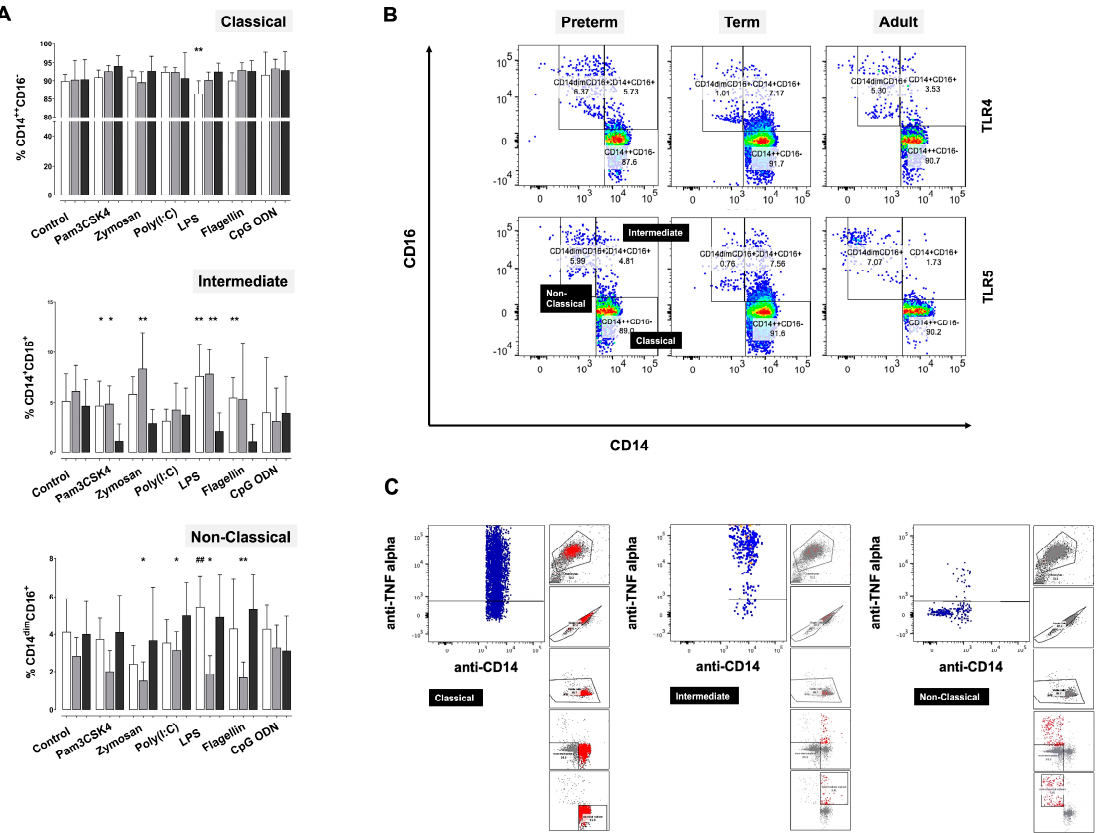
Figure 4. ( A ) Frequencies of CD14 ++ CD16 − (classical), CD14 + CD16 + (intermediate), and CD14 dim CD16 + (non-classical) monocyte subsets at baseline and in TLR-stimulated preterm CB (white bars), term CB ( grey ), and adult monocytes ( black ) as assessed by flow cytometry (* p < 0.05; ** p < 0.01 vs. adult; ## p < 0.01 vs. term CB). ( B ) Representative dot plots of monocyte subpopulations upon stimulation with LPS (TLR4 ligand) and flagellin (TLR5). ( C ) Representative dot plots of TNF- α /surface marker co-staining in LPS-stimulated preterm CB monocytes. The ancestry panels of each dot plot display the backgating of each subset as well as the gating strategy applied. Monocytes were identified via forward and side scatter. Doublets and dead cells were excluded, as was the population of “not CD14 + CD16 + monocytes”. Frequencies of classical (CD14 ++ CD16 − ), intermediate (CD14 + CD16 + ), and non-classical (CD14 dim CD16 + ) monocytes were determined using rectangular gating.